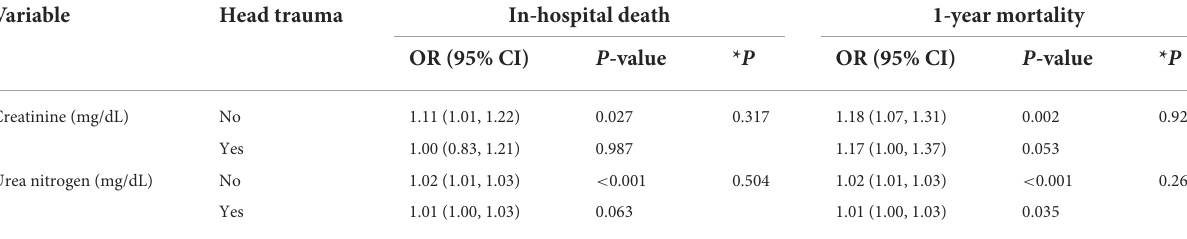
TABLE 5 Subgroup analysis by “head trauma” for associations of blood creatinine and urea nitrogen with hospital mortality and 1-year mortality in ICU patients with intracranial hemorrhage.